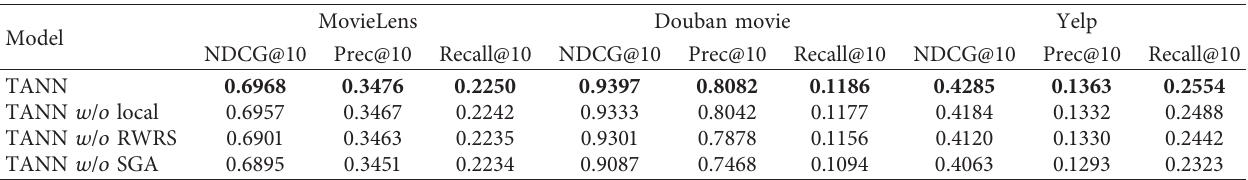
Table 3: Experimental results of TANN-based recommendation approach on the four datasets.